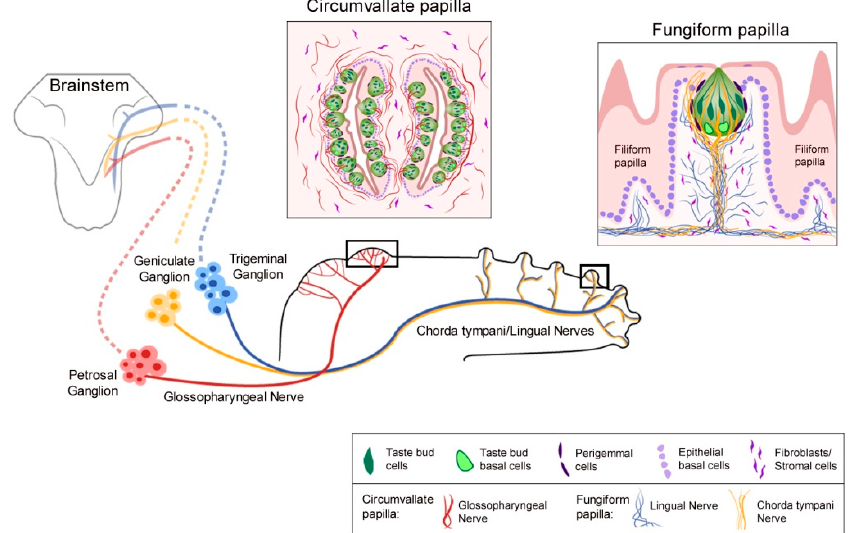
Figure 1. Lingual taste system. The tongue in sagittal section and sensory ganglia are diagrammed, with nerve projections to the anterior and posterior tongue and papillae. Ordered central projections from ganglia to the brainstem are diagrammed in hatched lines. The chorda tympani/lingual nerve projections, from the geniculate (chorda tympani) and trigeminal (lingual) ganglion neurons to the anterior tongue, enter the tongue in a common bundle but redistribute within the papillae to gustatory (chorda tympani) and non-gustatory (lingual) papilla tissues. Glossopharyngeal nerve projections from petrosal ganglion neurons are to the posterior tongue and circumvallate papilla. Not illustrated, the glossopharyngeal nerve also innervates the gustatory foliate papillae in the posterior lateral walls of the tongue. Boxed diagrams are as follows: The circumvallate papilla with multiple and contiguous taste buds in the papilla epithelial walls. The fungiform papilla with a single apical taste bud in the epithelium, covering a broad connective tissue core with stromal cells and innervation. In addition to directly entering into the taste bud, the chorda tympani nerve extends fibers into the apical epithelium. Non-taste filiform papillae bracket the fungiform papilla. The glossopharyngeal nerve innervates taste buds in the circumvallate papilla and papilla connective tissues. The boxed legend refers to elements in the circumvallate and fungiform papilla diagrams.